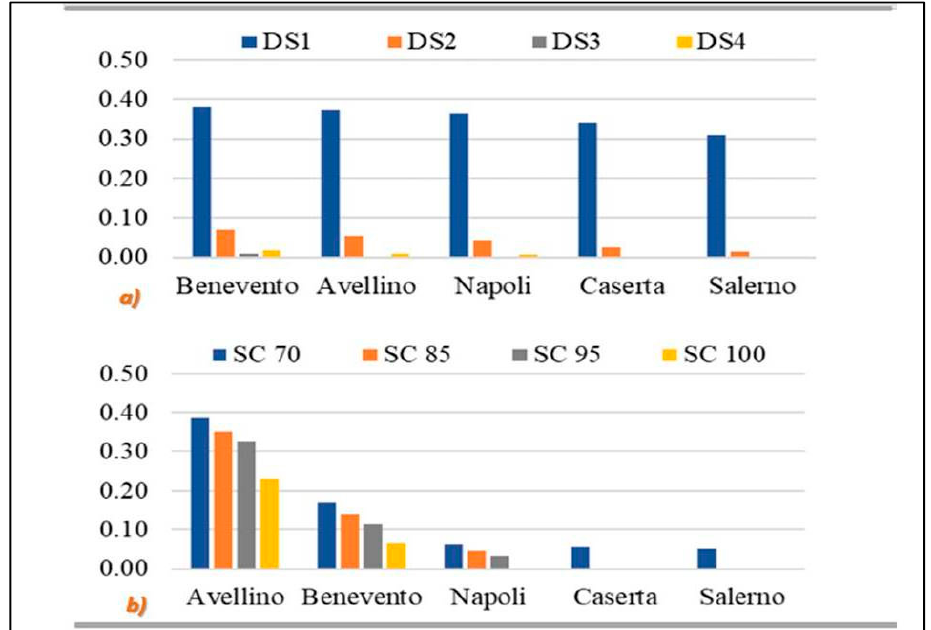
Figure 12. 2-storey building Campania region: ( a ) damage scenario; ( b ) energy quality.